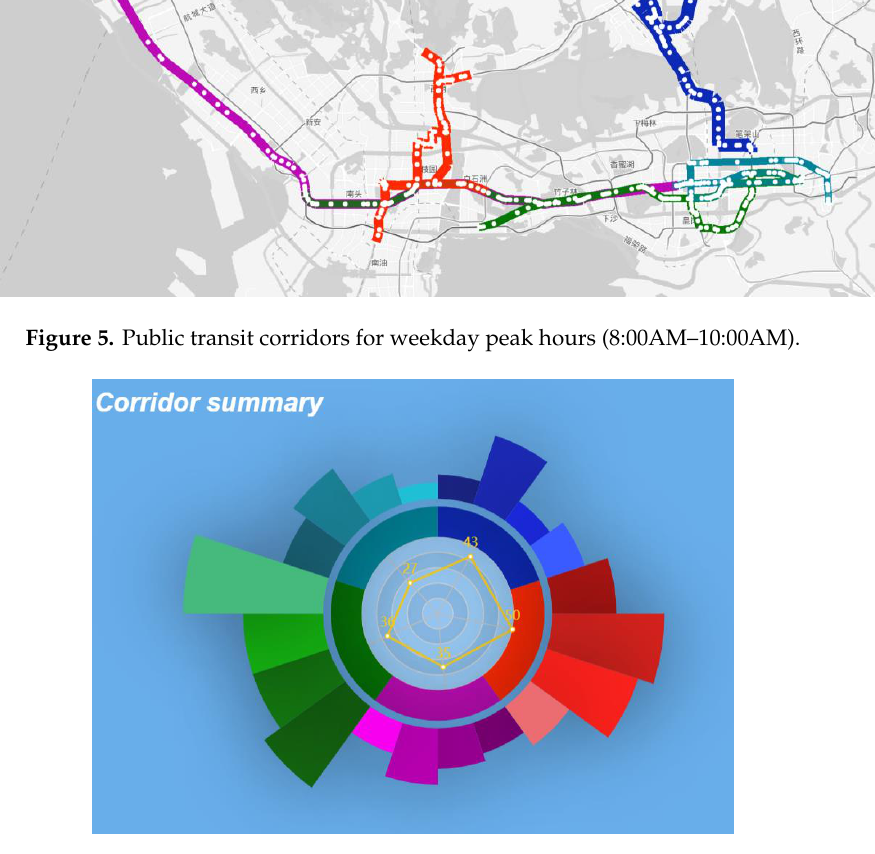
Figure 6. Corridor summary glyph. ISPRS Int. J. Geo-Inf. 2019 , 8 , x FOR PEER REVIEW